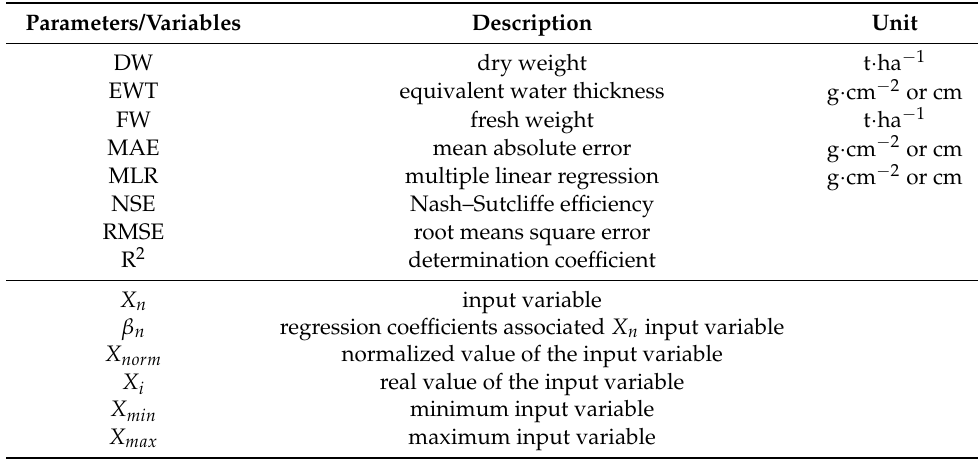
Table 2. Description of parameters and variables.